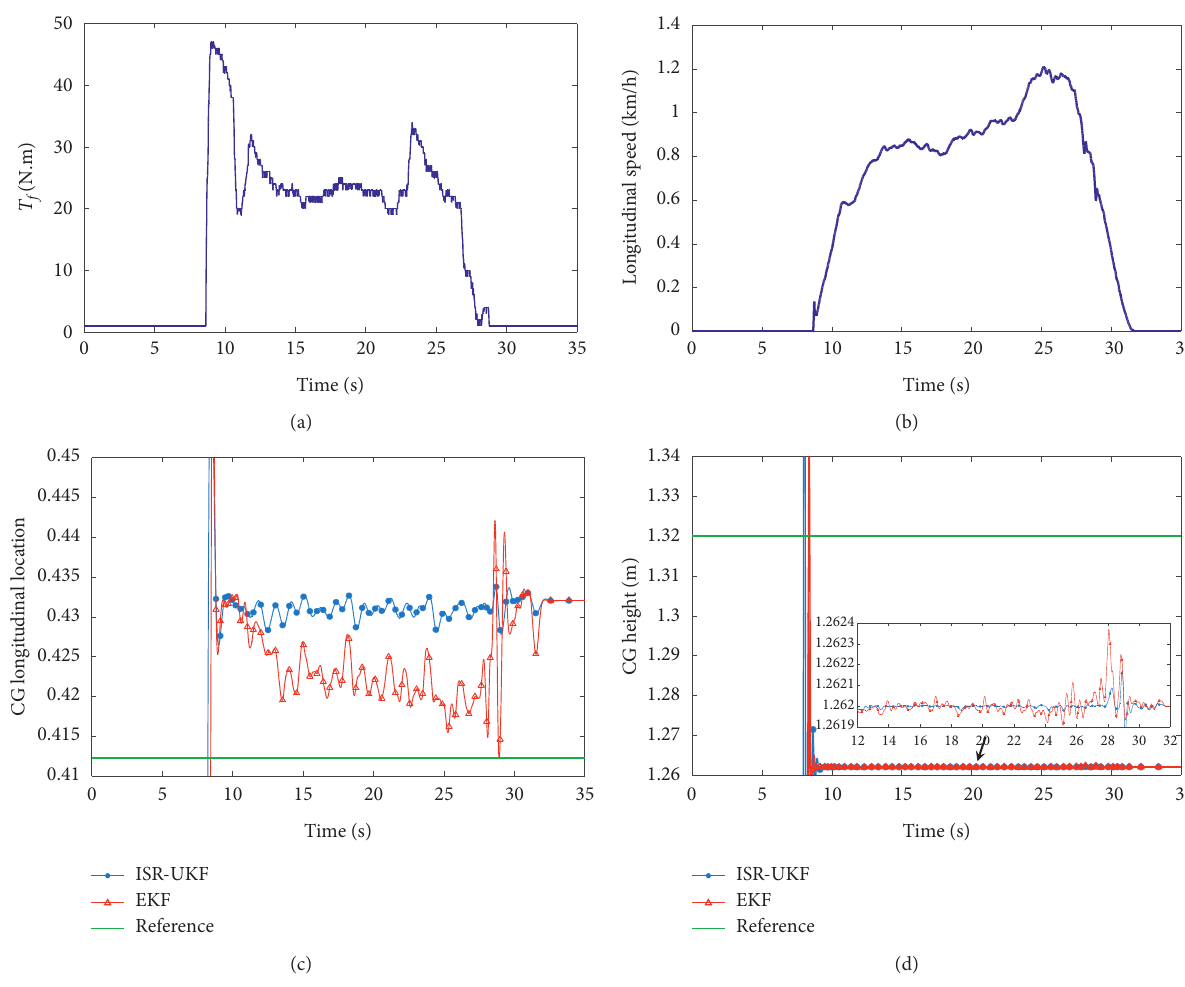
Figure 8: Acceleration and deceleration experiment. (a) Output torque of the front motor; (b) longitudinal speed; (c) CG longitudinal location; (d) CG